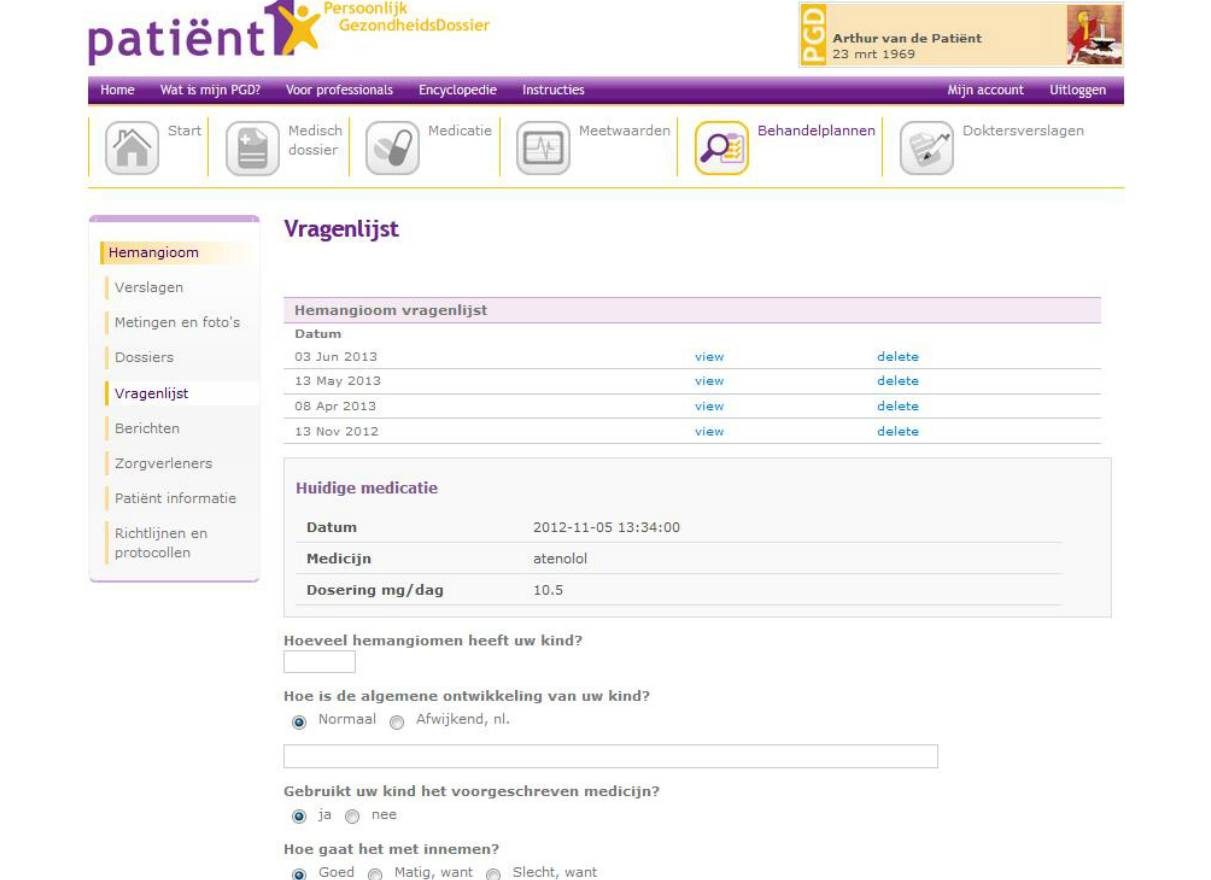
Figure 2. Screenshot of the Hemangioma Treatment Plan (in Dutch) showing the page where parents fill in standardized questionnaires about side-effects prior to consultation (fictitious patient in a test